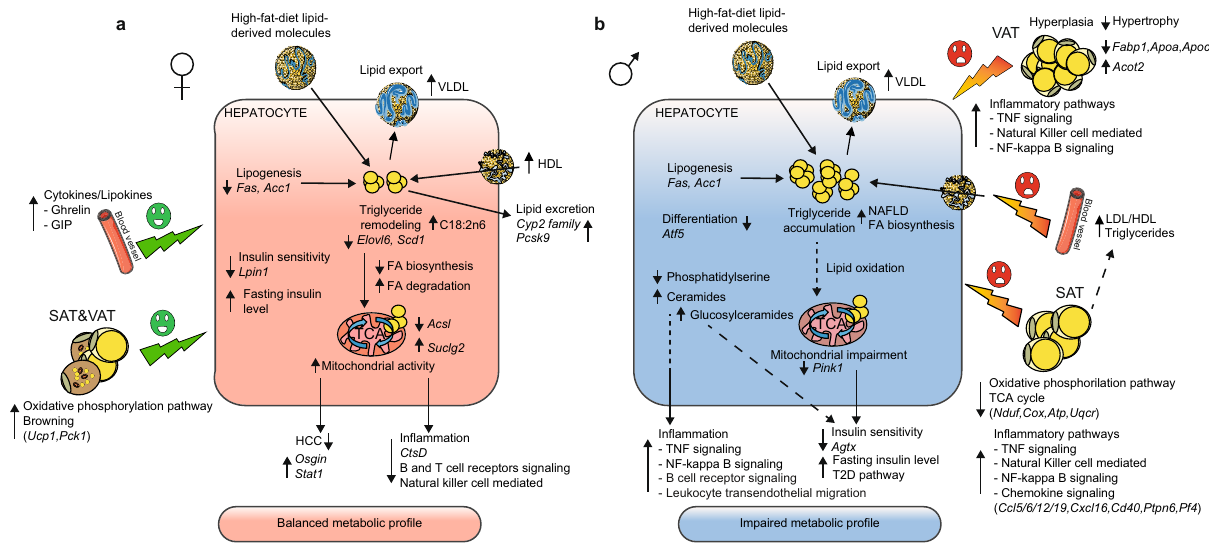
Fig. 6 Sexually programmed metabolic response in the obese offspring exposed to maternal obesity. a Livers from female offspring demonstrate reduced insulin sensitivity and decreased lipogenesis and in fl ammatory pathways, decreased hepatocarcinoma and remodeling of triglyceride species. Oxidative phosphorylation and browning processes are increased in SAT and VAT, respectively. Circulating cytokine and lipokine levels, ghrelin and GIP are higher in F-moHF compared to F-moC and to M-moHF. Altogether, these metabolic adaptations would protect the liver from later metabolic complications in response to MO. b Livers from male offspring demonstrate induced lipogenesis and steatosis, induced glucosylceramides production and increased in fl ammation possibly due to negative feedback signaling from the adipose tissue (reduction of oxidative phosphorylation associated with an induction of in fl ammatory pathways) which would promote metabolic disorders. Arrows stand for up- ↑ and down- ↓ regulation. HCC, hepatocellular carcinoma; SAT, subcutaneous adipose tissue; VAT, visceral adipose tissue; VLDL, very low; LDL, low and HDL, high-density